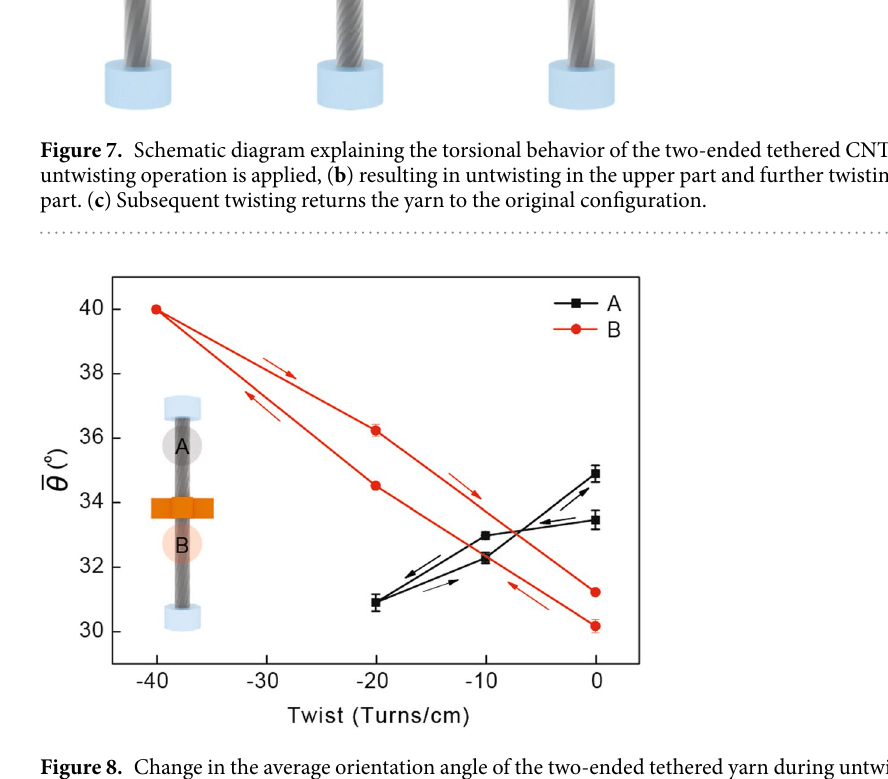
Figure 8. Change in the average orientation angle of the two-ended tethered yarn during untwisting and retwisting operations. Arrows indicate the untwisting and retwisting directions. Legends A and B indicate the measurement regions as shown in the